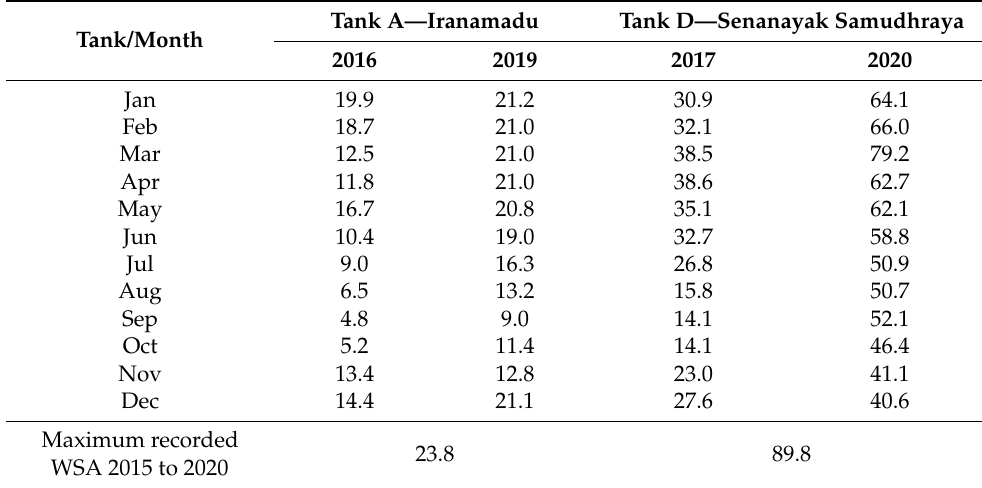
Table 4. Water surface area in square kilometers (sq.km) for drought year (2017), non-drought year (2019 and 2020), and maximum recorded WSA from 2015 to